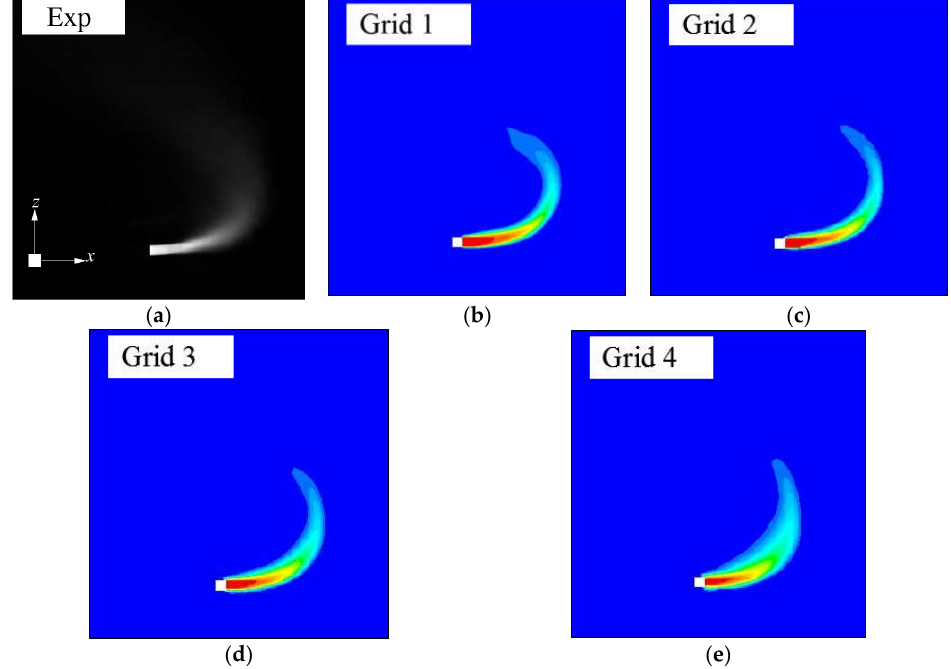
Figure 7. Comparison of the jet concentration fields between the experimental LIF image and simulated contours in the plane of y = 0: ( a ) experimental LIF image [16], and ( b – e ) simulated contour for grids 1–4.